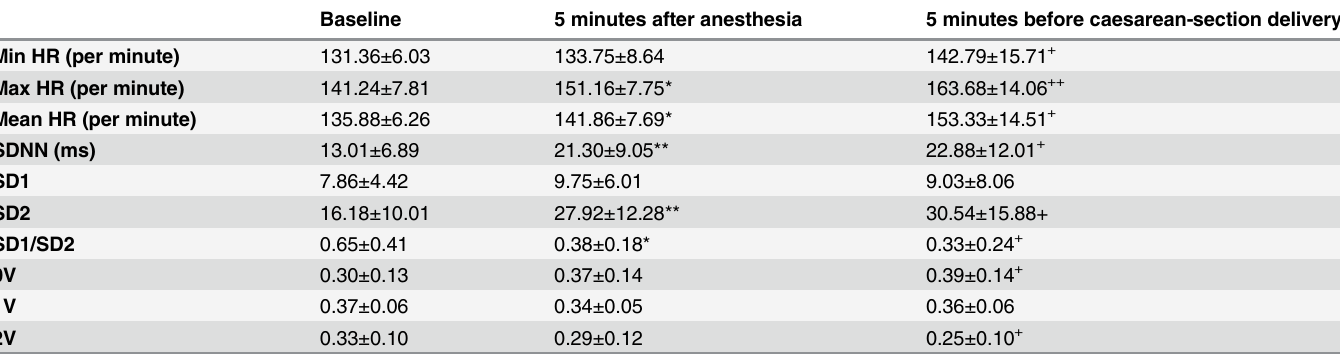
Table 1. Temporal evolutional changes of time domain HRV parameters and autonomic nervous function measures (Poincaré method) for Baseline (preparing for operation), 5 minutes after anesthesia and 5 minutes before caesarean-section delivery. Baseline 5 minutes after anesthesia 5 minutes before caesarean-section